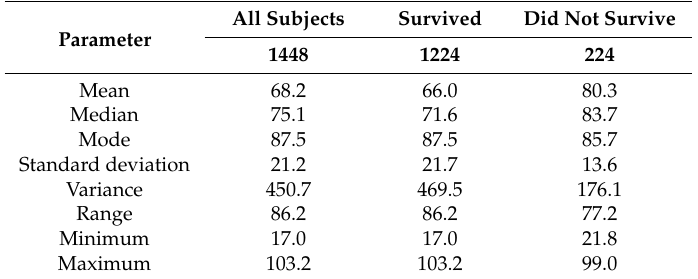
Table 4. Age (in years) statistical summary for subjects in the validation dataset.